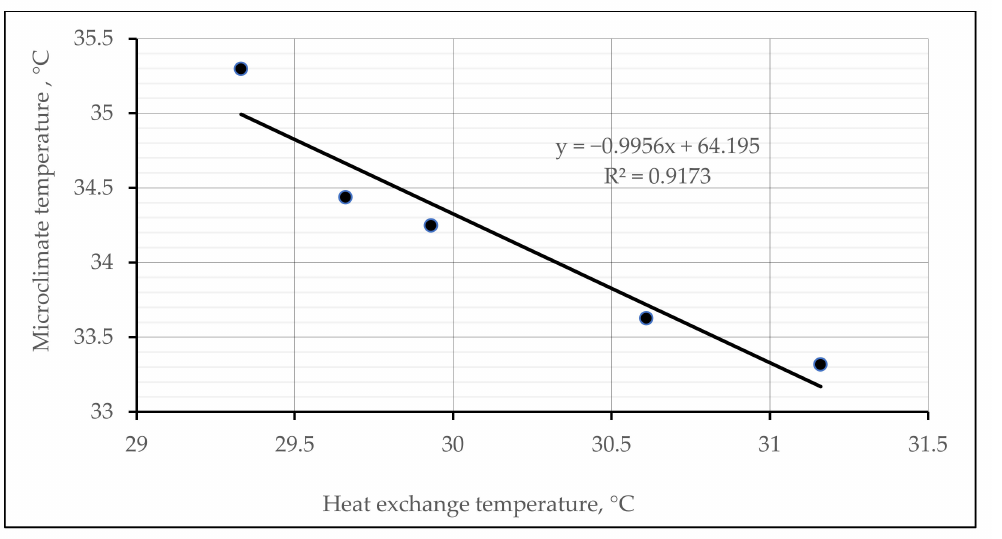
Figure 11. Relationship between the microclimate and heat exchange temperatures of different structures of socks.